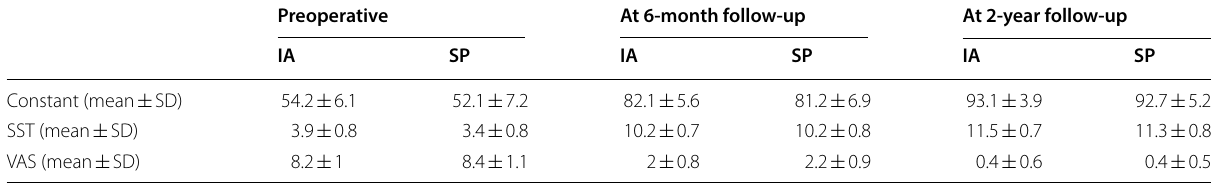
Table 2 Primary (Constant and SST scores) and secondary (VAS score) outcomes in both groups Preoperative At 6-month